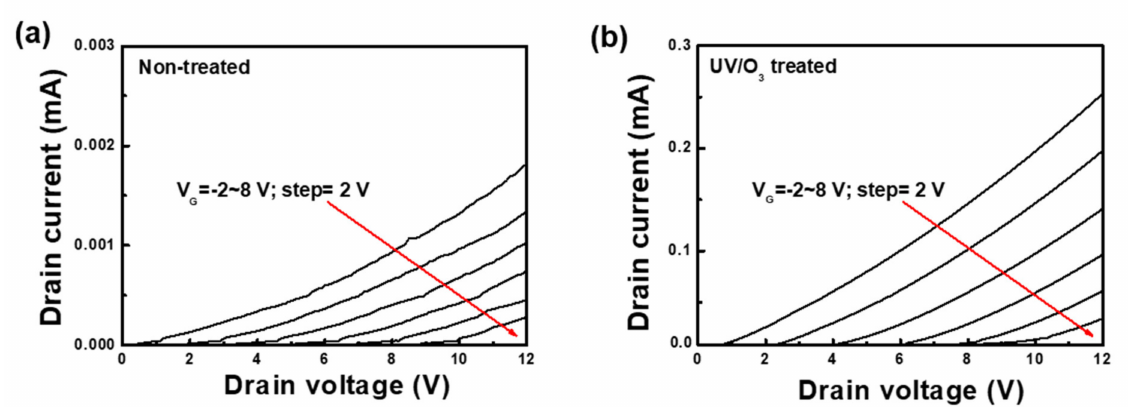
Figure 5. Measured electrical characteristics of Ga 2 O 3 /4H-SiC static induction transistor: I D -V D of ( a ) non-treated and ( b ) UV/O 3 treated for 30